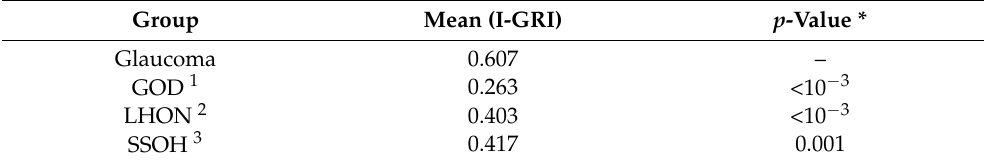
Table 13. Three means of the I-GRI for the glaucoma and glaucoma-like groups. Group Mean (I-GRI) p -Value * Glaucoma 0.607 – GOD 1 0.263 <10 − 3 LHON